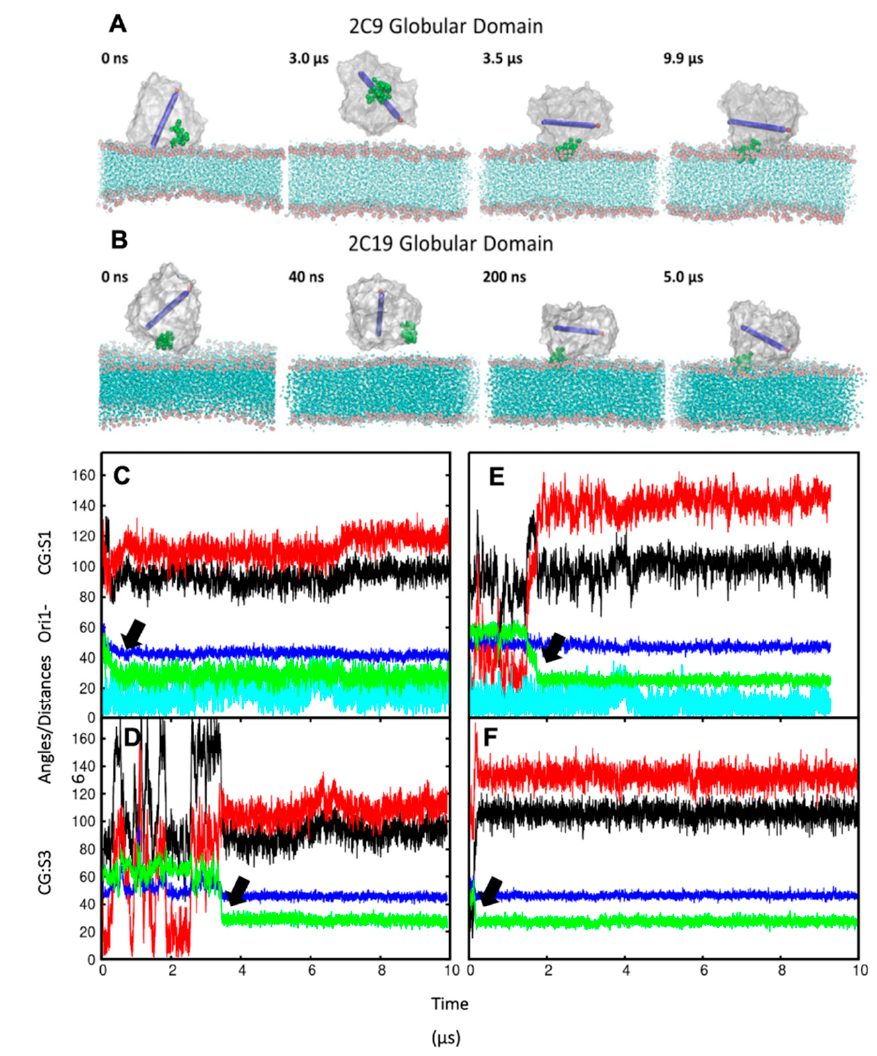
Figure 3. ( A , B ) Snapshots from CG simulations of globular domains (S3) of ( A ) CYP 2C9 and ( B ) CYP2 C19 showing exploration of different orientations followed by convergence to the same orientation as observed for CG simulations of the full-length wild-type proteins. The globular domain is shown with a silver surface representation, with the F’–G’ helices shown as green VDW spheres and the I-helix (residues 286–316) shown as a blue cylinder with an arrow and a red sphere at the C-terminal end. The 1-palmitoyl-2-oleoyl-sn-glycero-3-phosphocholine (POPC) bilayer is shown in cyan, with the phosphate atoms in the head groups shown as red spheres. ( C – F ) Convergence of the orientation and position of the globular domain during CG simulations of CYP 2C9 ( C , D ) and CYP 2C19 ( E , F ). The angles (°) and distance (Å) values vs time (µs) are shown for selected trajectories from CG systems: ( C , E ) S1 (full-length proteins); ( D , F ) S3 (globular domain only). The angles α (black), β (red), and the TM-helix tilt angle (cyan) (defined in Figure 2 and Materials and Methods) are shown along with the axial distances of the bilayer CoM to the CoM of the globular domain (blue) and the F’–G’ helices (green). The thick black arrows point to the decrease in the distance of the F’–G’ helices from the membrane center, which is coincident with convergence to stable orientations.